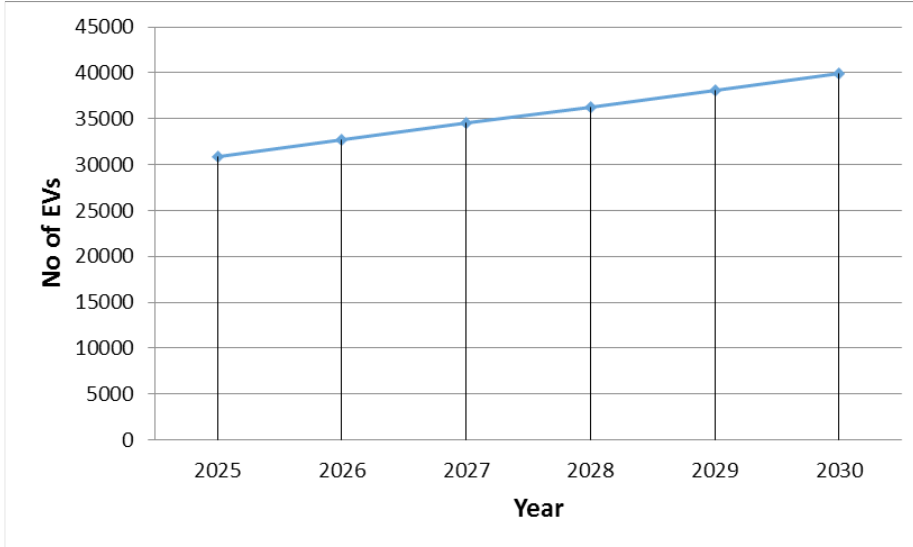
Figure 3(b): EV predictions from 2025 -